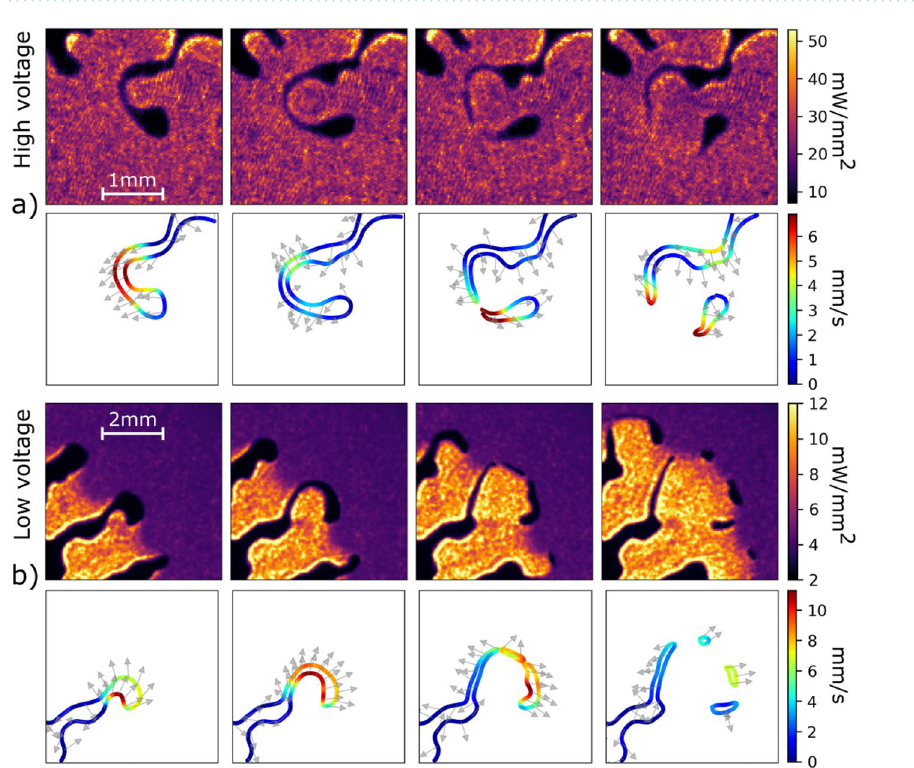
Figure 4. Secondary droplets generation in ( a ) high and ( b ) low voltage plasma. The high voltage sequence starts 1.4 s after the voltage switch-on, low voltage sequence after 3.5 s. The time step between the consecutive frames is 58